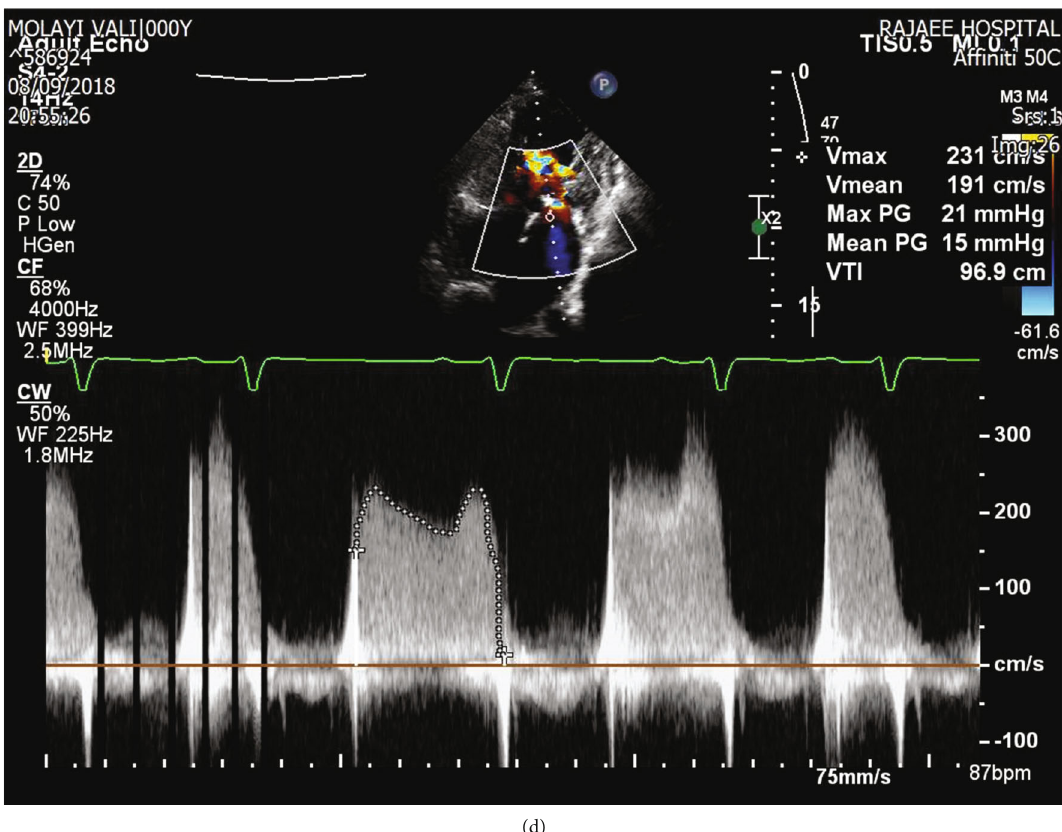
Figure 1: Transthoracic echocardiography in 4-chamber view shows (a) morphologic LV which is the right side of rudimentary RV, (b) large inlet type VSD, very small ASD, (C) PA originate from the main ventricle with con fl uent PABs, (d) Thick and hypo plastic left AV valve severe stenosis (MG:15, PG:21).